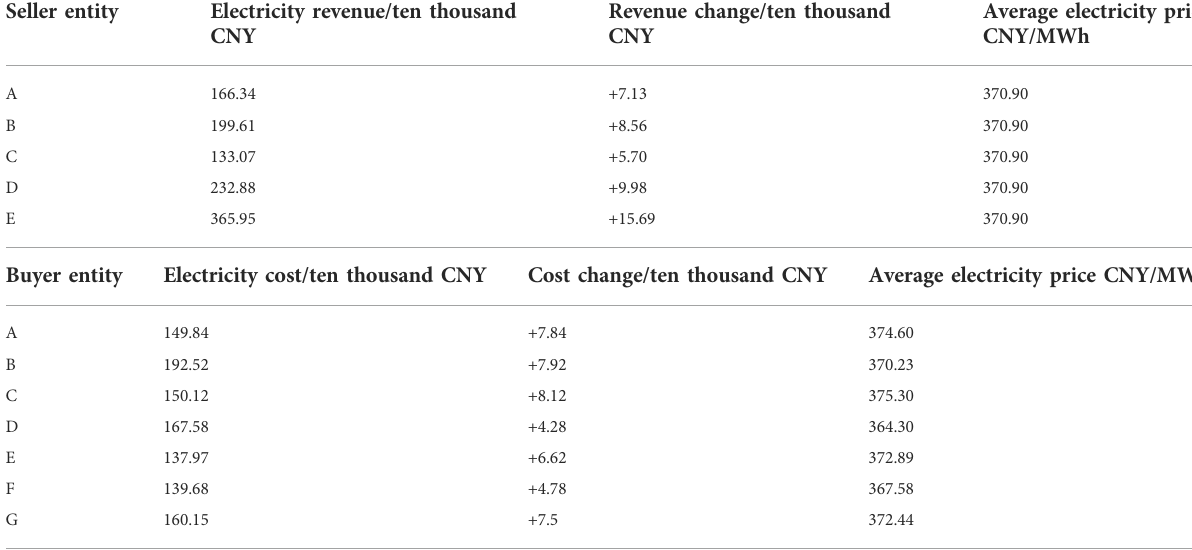
TABLE 6 Settlement of market entity under the paid as bid